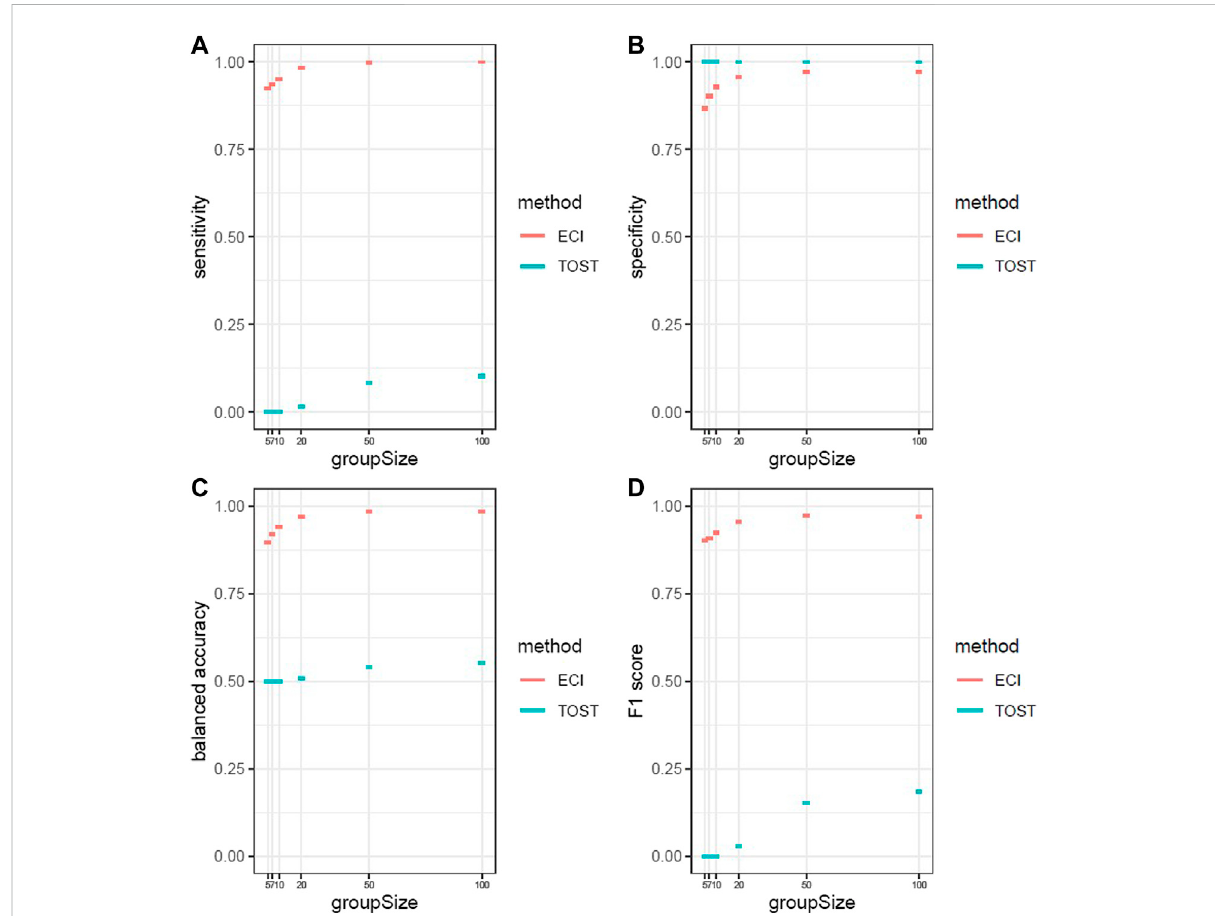
FIGURE 4 Performance metrics with 95% con fi dence intervals of 1,000 iterations for ECI bootstrap test and two one-sided t -test (A) Sensitivity (B) speci fi city) (C) balanced accuracy (D) F1 score. The ECI bootstrap test shows increasing performance with increasing group size and has overall a good performance. TheTOSTshows onlyinspeci fi cityabetterperformance thantheECIbootstraptestand showsno performancefor all theother